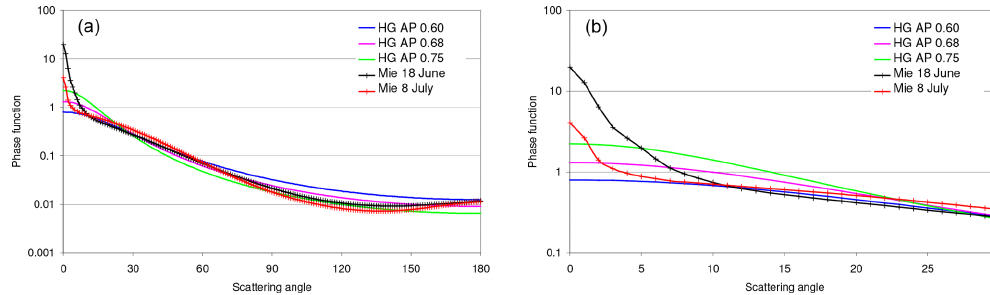
Figure 10. Comparison of different aerosol phase functions used in the radiative transfer simulations. Panel (b) is a close-up of (a)